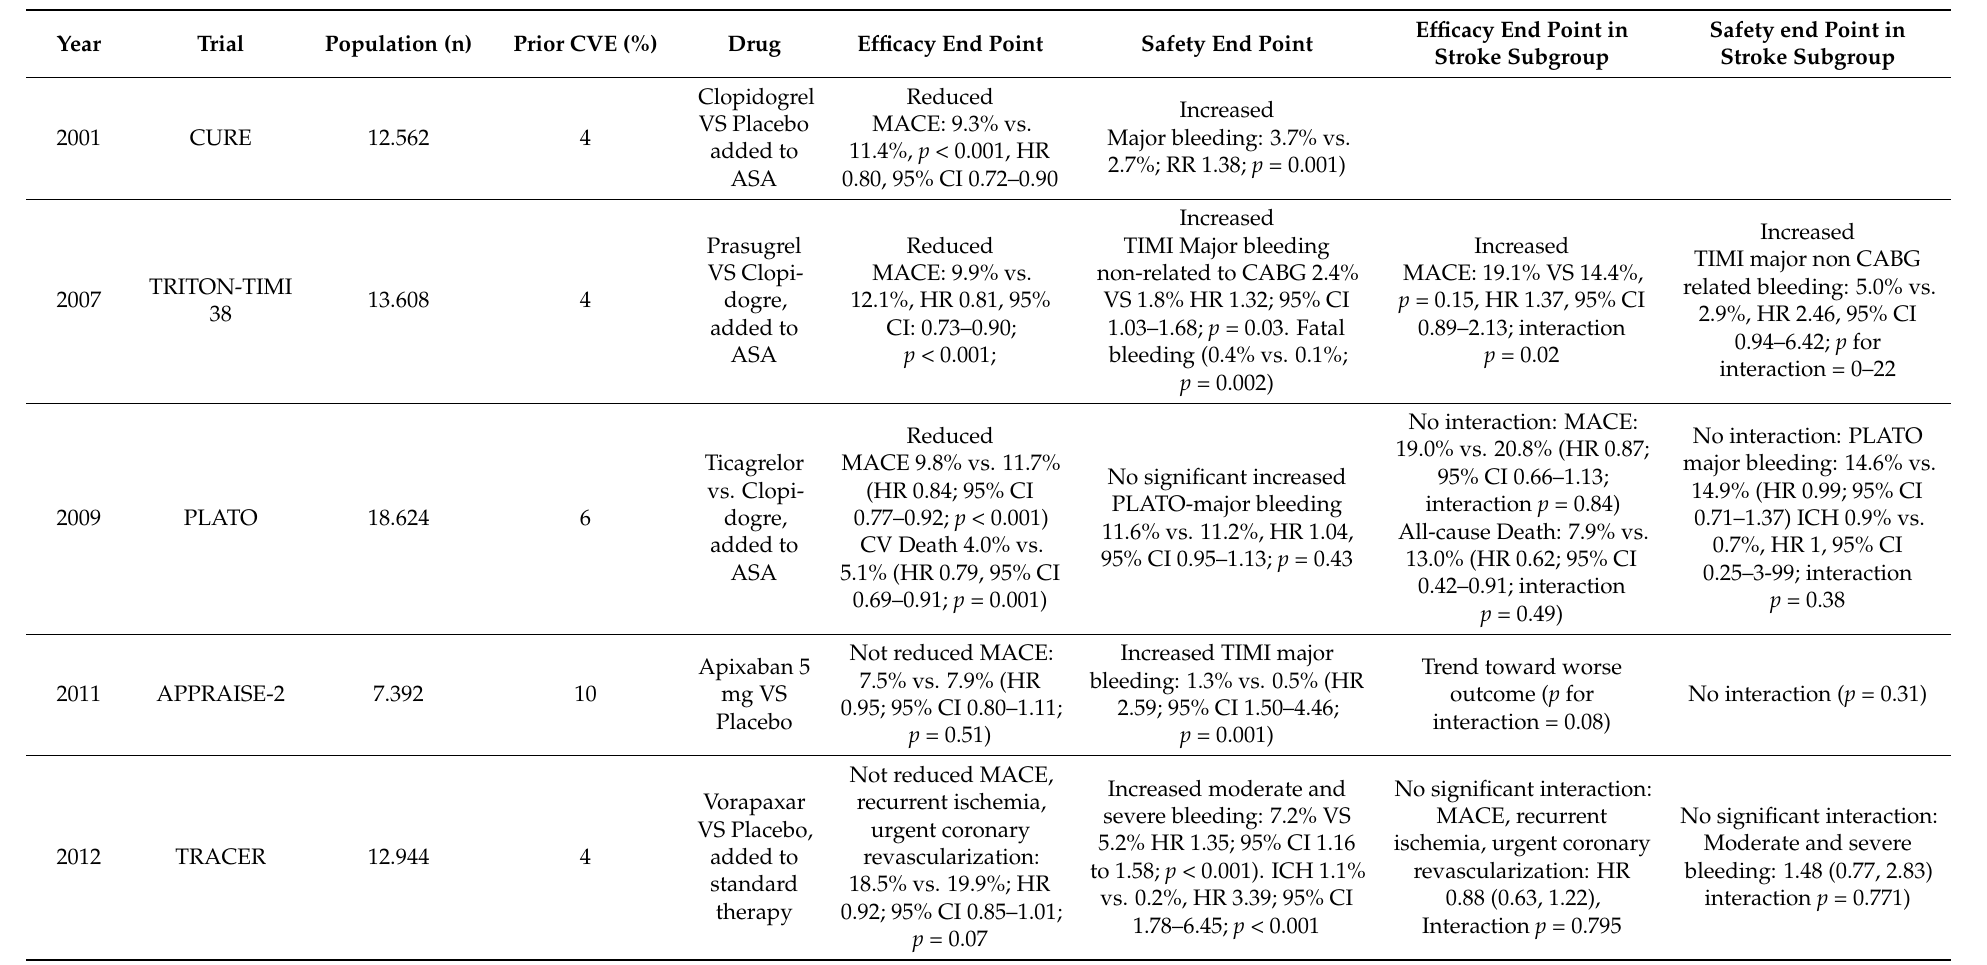
Table 1. Major trials on antithrombotic therapies in